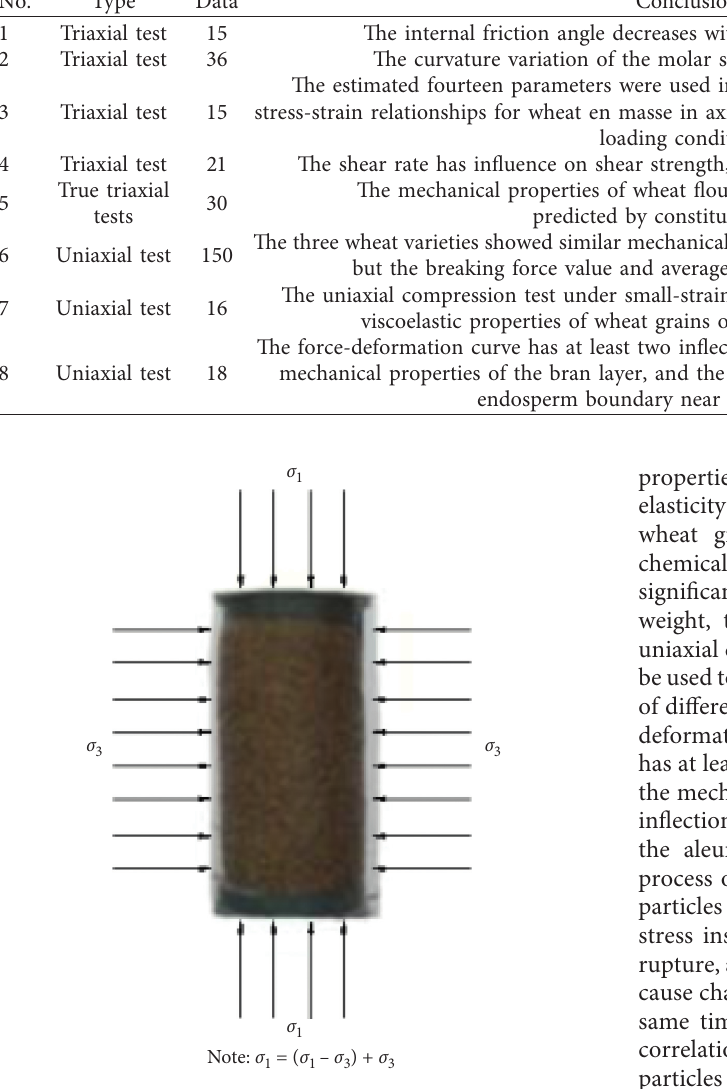
Figure 1: Schematic diagram of the force in the triaxial test of wheat.